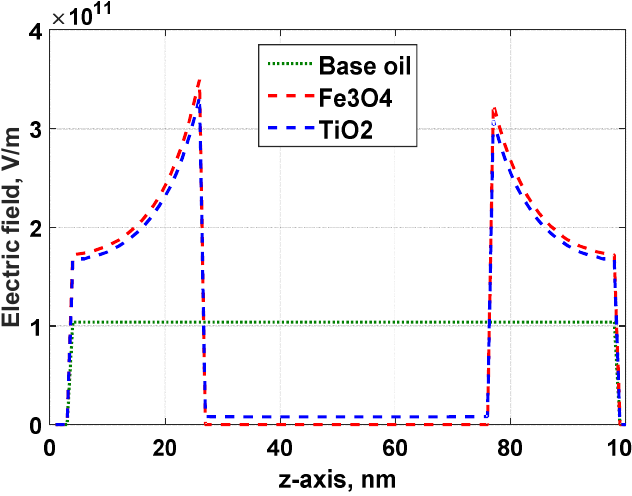
Figure 10. Cross section plot of the electric field magnitude from the FEA model in Figure 9.